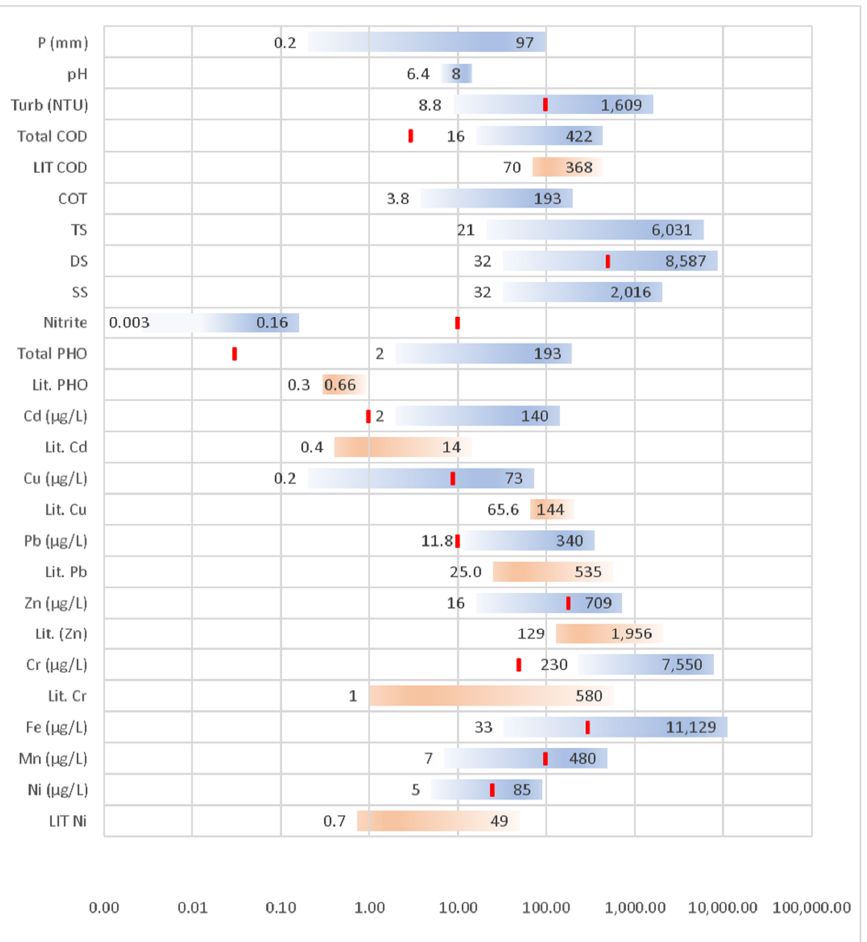
Figure 3. Range of concentrations sampled in runoff inflow to the Campeche infiltration swale